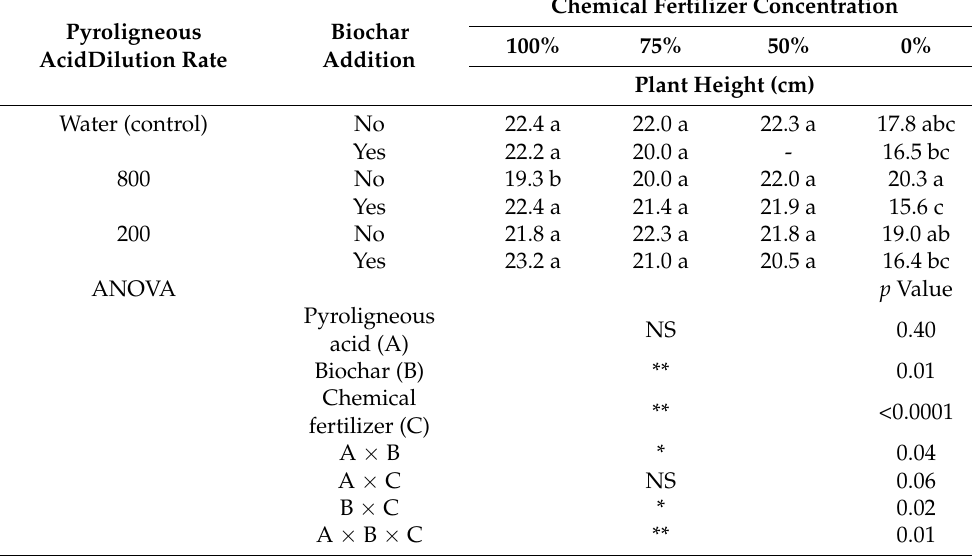
Table 5. The effect of pyroligneous acid (PA) and biochar on plant height of Komatsuna ( Brassica rapa var. perviridis ). × 800 and × 200 represent PA dilution rates: 1 part PA, and either 800 or 200 parts water. Different lowercase letters indicate significant difference at p < 0.05. NS: not significant, **: p -value < 0.01, *: p -value < 0.05. Chemical Fertilizer Concentration Pyroligneous Biochar 100% 75% 50% 0% AcidDilution Rate Addition Plant Height (cm) Water (control) No 22.4 a 22.0 a Yes